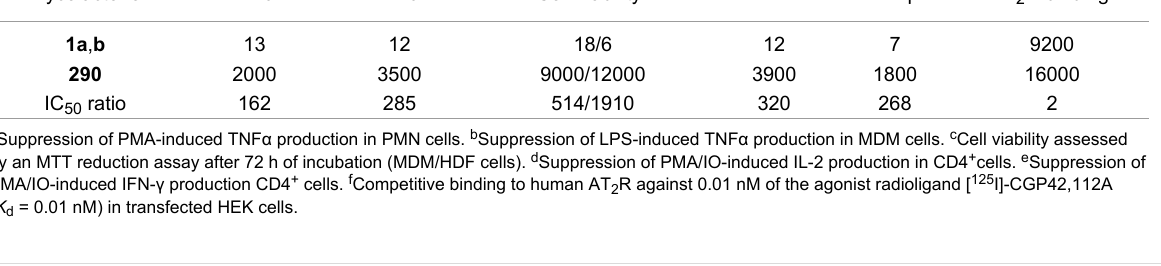
Table 6: Diverse biological activities of mycolactone A/B ( 1a , b ) and 290 (IC 50 [nM]). Mycolactone